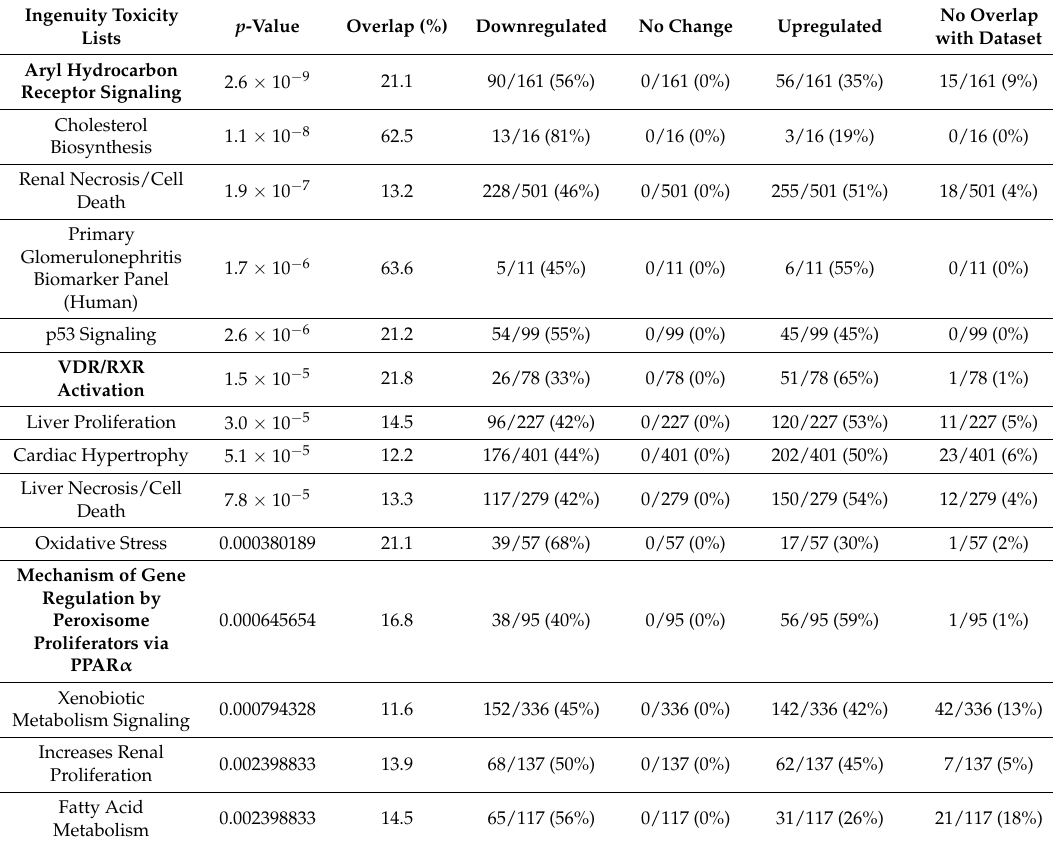
Table 11. Toxicity-related pathways identified by Ingenuity in human keratinocytes treated with 20,23(OH) 2 D3 for 24 h. Nuclear receptors are marked in